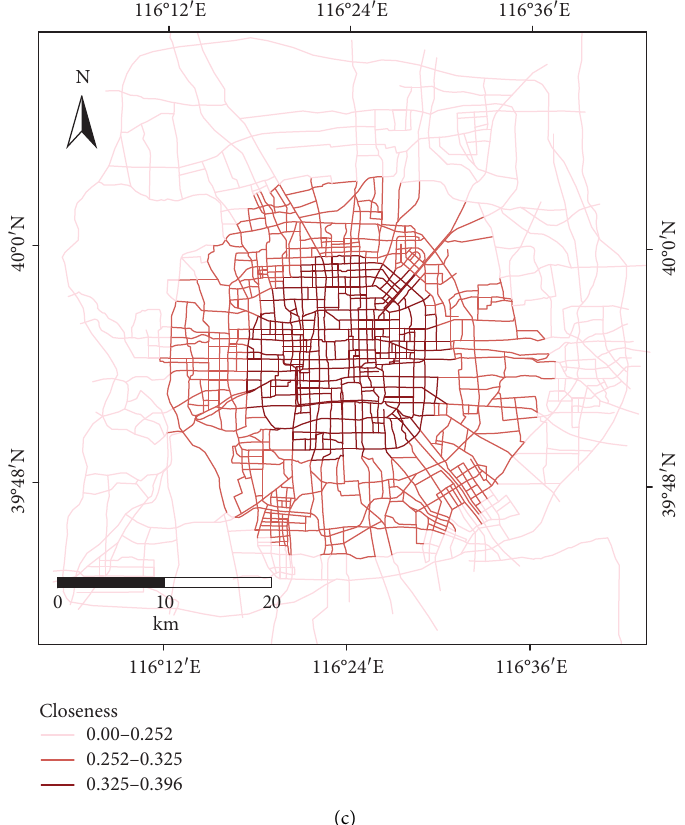
Figure 10: Road centrality distribution: (a) betweenness centrality; (b) straightness centrality; (c) closeness centrality.